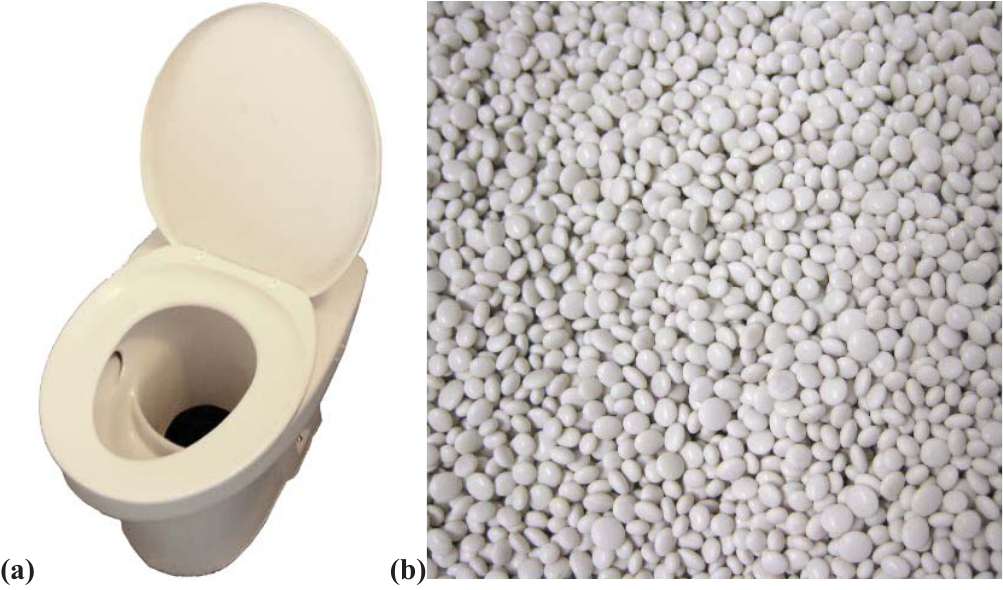
Figure 7. Examples of phosphorus recovery in the wastewater sector (WS1): ( a ) onsite, low-tech, urine-diverting composting toilet, ( b ) struvite recovered from high-tech crystalisation of mixed wastewater (Photo source: Dana